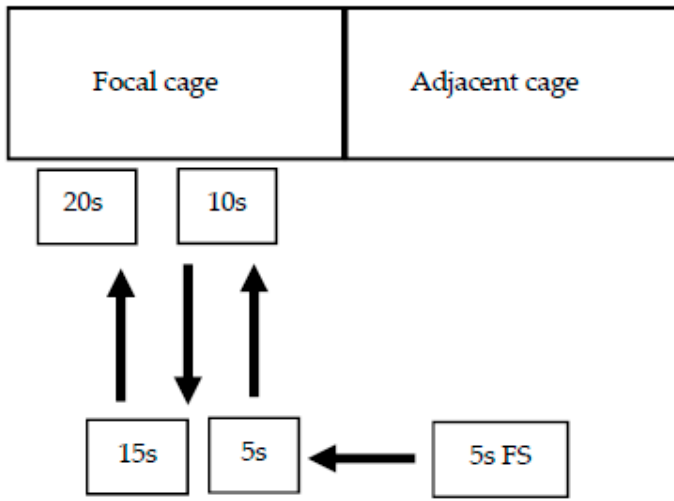
Figure 1. Movement of the researcher during the four stages of the Approaching Human Test. 5s FS = 5-second familiarization stage prior to the test commencing.